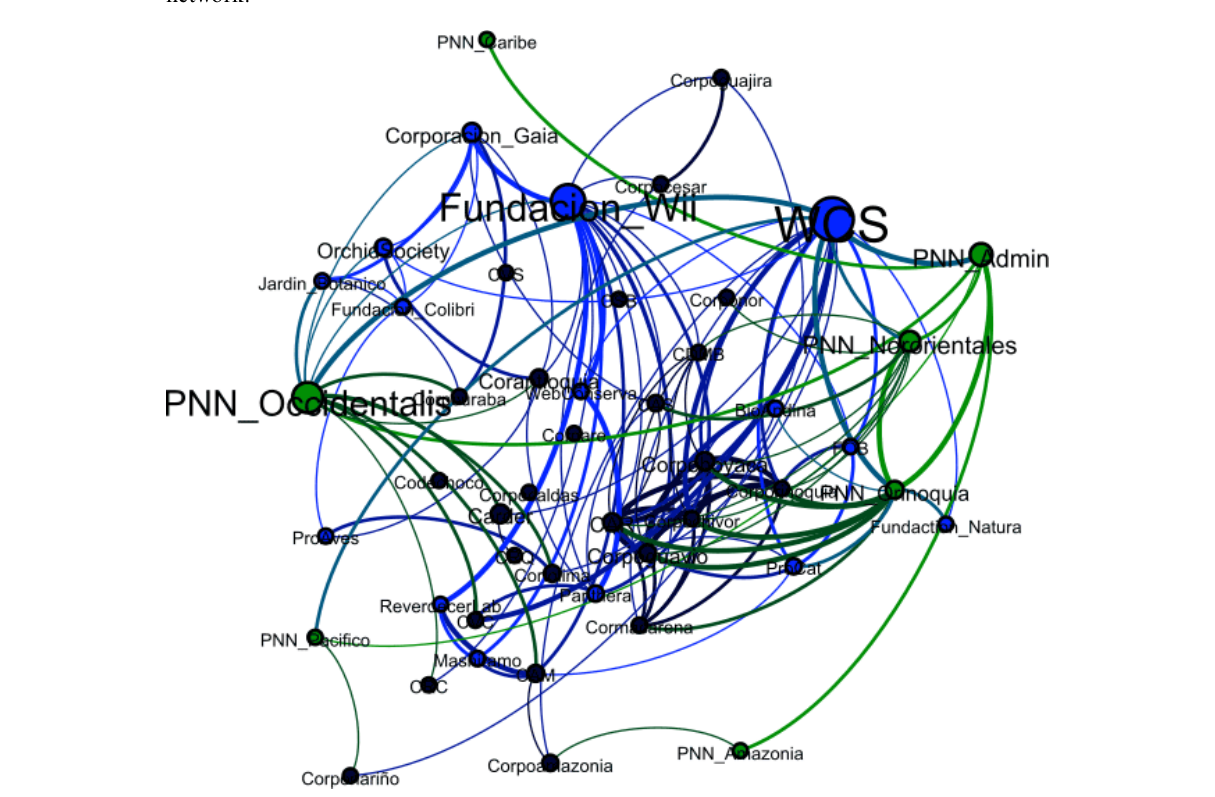
Fig. 6 . Complex social network among the autonomous regional corporations ( corporaciones autonomas regionales [CARs]; black nodes), entities of Colombia’s National Natural Park Service (green), and nongovernmental organizations (blue). Thicker lines are indicative of stronger institutional ties regarding Andean bear ( Tremarctos ornatus ) conservation and research. Node size is indicative of relative degree centrality of each organization in the